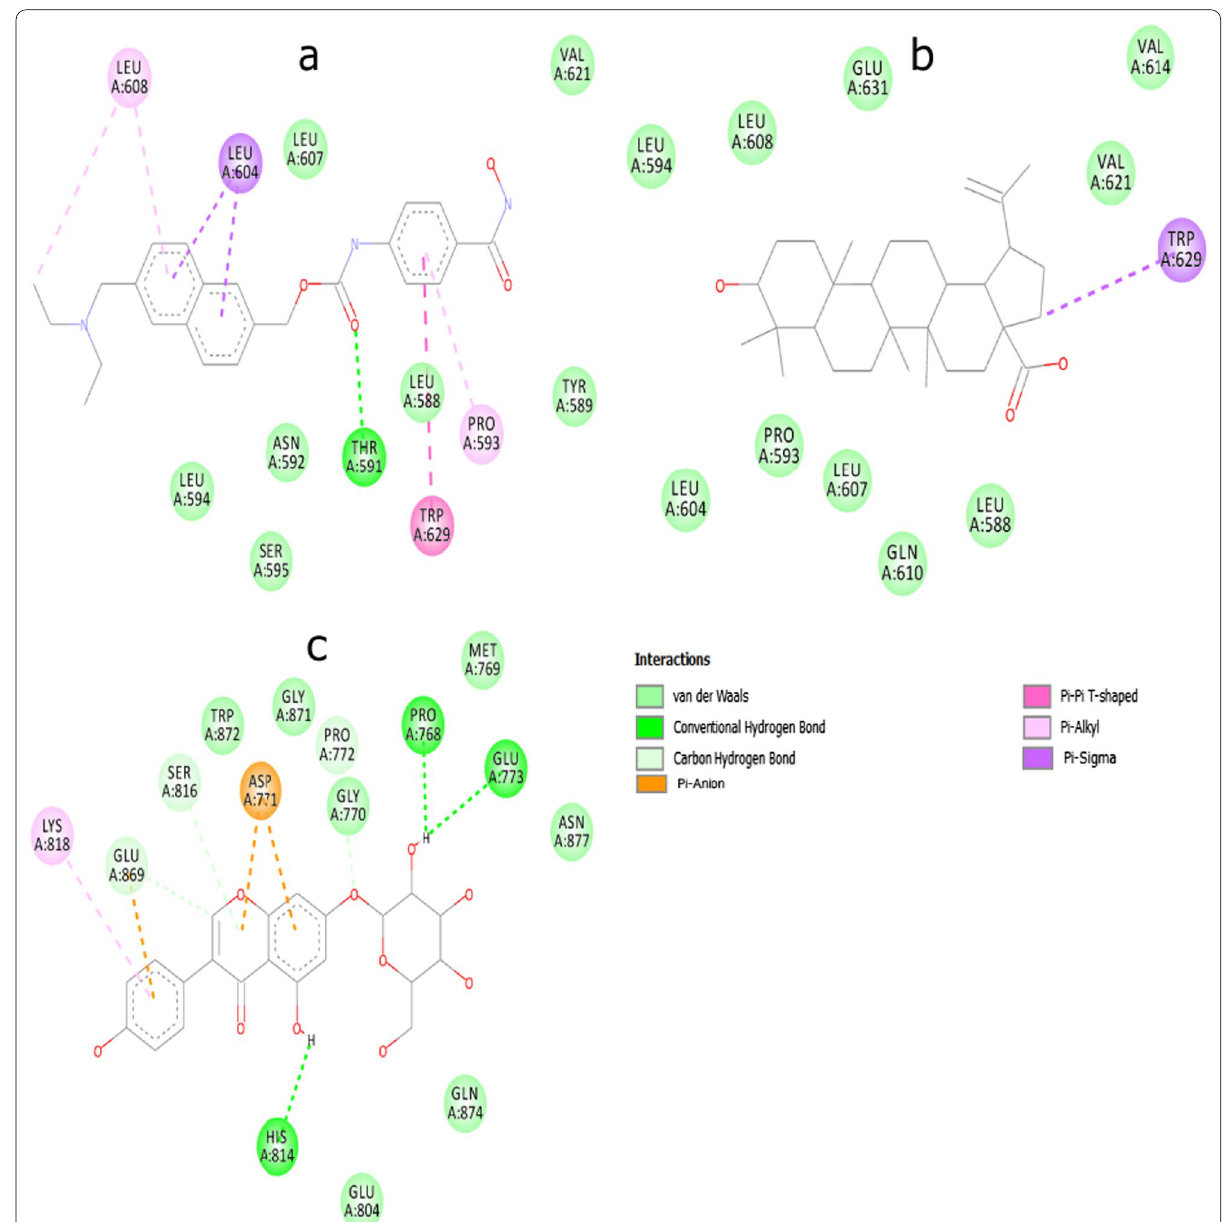
Fig. 7 2D view of the interaction between a givinostat b betulinic acid c orientin and amino acids in the binding sites in histone deacetylase